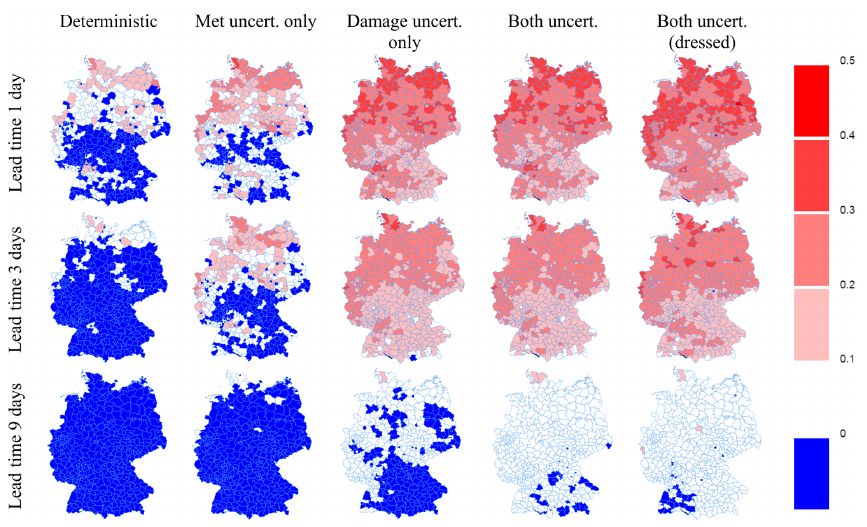
Figure 6. Brier skill score (employing climatology as reference forecast) for events with loss ratio exceeding low threshold (0.0001‰) in the period 2006–2009 ( © GeoBasis-DE/BKG